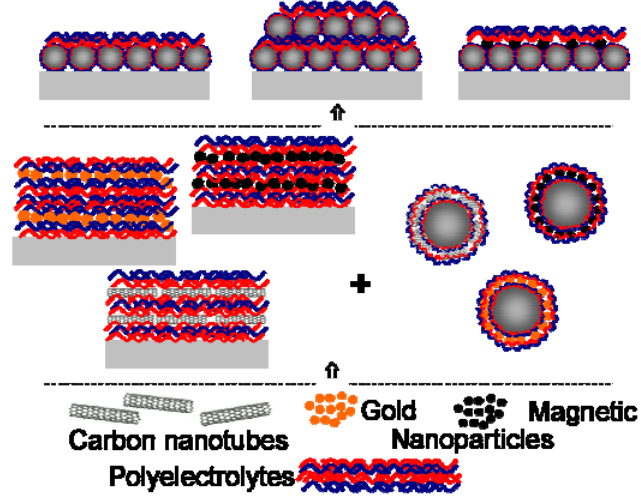
Figure 1. Schematics of the bottom-up assembly of planar films and spherical particles using polyelectrolyte multilayers, particles, nanoparticles and carbon nanotubes (the bottom row and the middle row). Evaporative self-assembly of particles and polyelectrolyte layers is also shown (the top